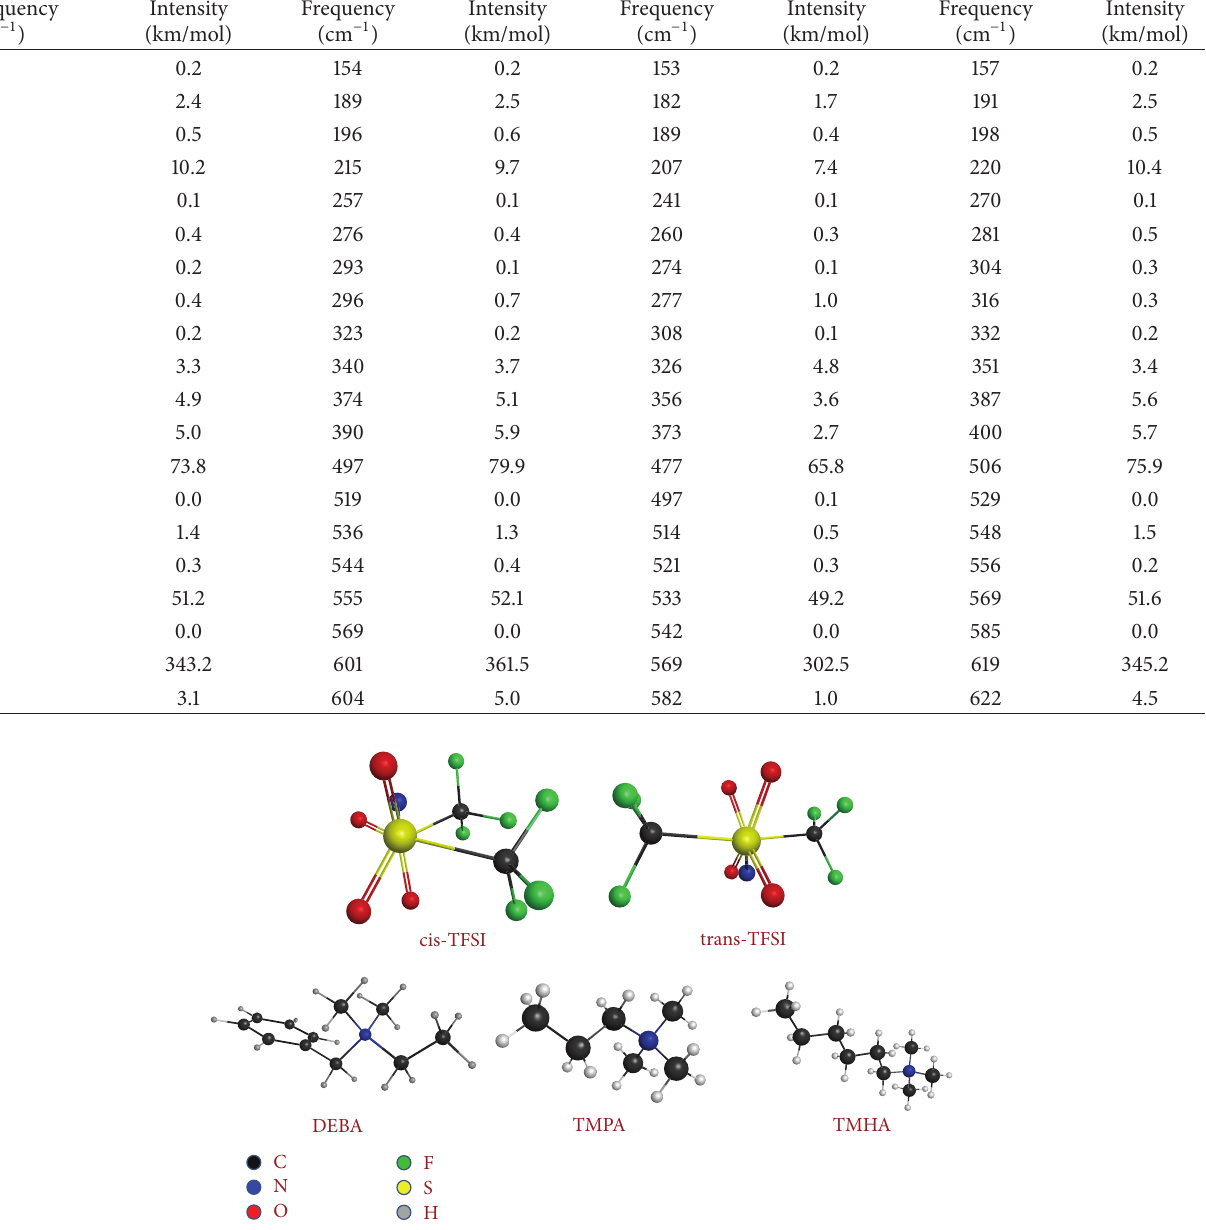
Figure 2: Geometry of cis-TFSI, trans-TFSI, TMPA, TMHA, and